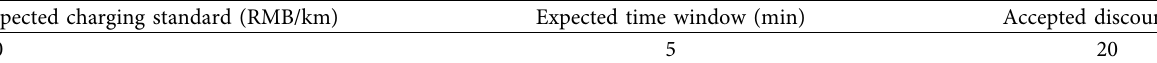
Table 4: Survey parameters and